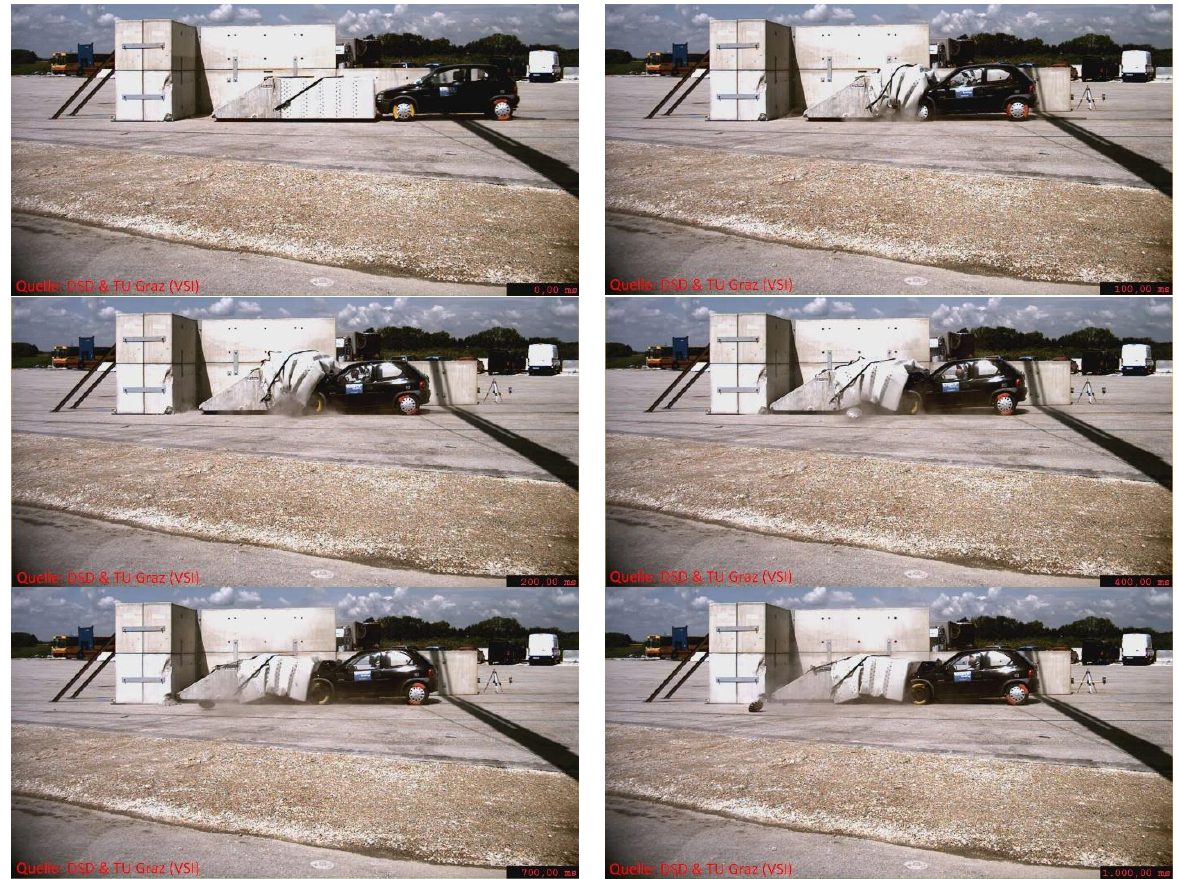
Figure 11. Vehicle motion impacting the crash cushion Alpina <prototype>. The vehicle was fully decelerated and moved backwards due to the elastic restitution. The final position was approximately 0.6 m in front of the damaged crash cushion.